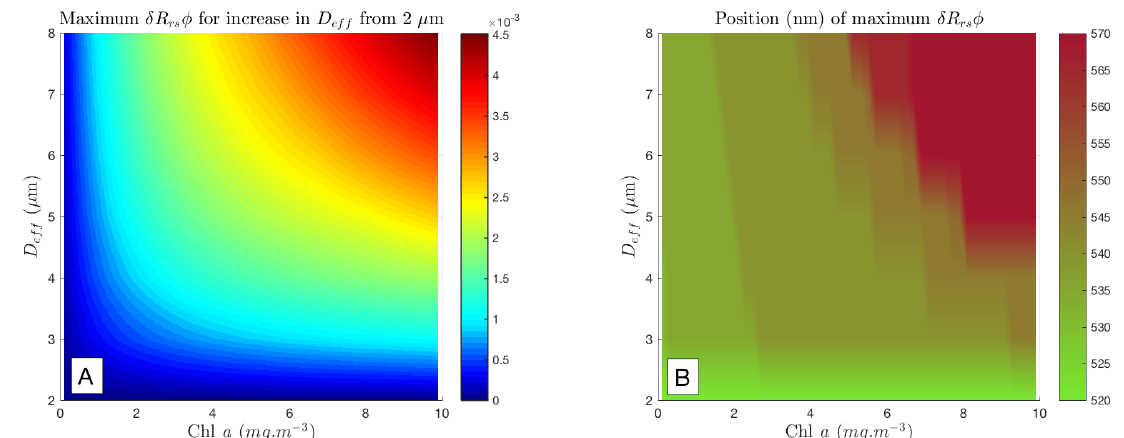
Figure 10. Maximum δ R rs φ for δ D ef f from a starting assemblage with D ef f 2 µ m, as Chl a varies ( A ). Note that the δ R rs φ occurs at different wavelengths from 500 to 600 nm ( B ), and this shows the maximum signal, so there is no exact wavelength information in ( A ). Using a difference of 1 × 10 − 3 sr − 1 as a threshold for detection by satellite, it can be seen that, while the maximum size change here (2 to 8 µ m) is not detectable with Chl a < 1 mg/m 3 , by 10 mg/m 3 , even a small change in D ef f results in a detectable change in R rs